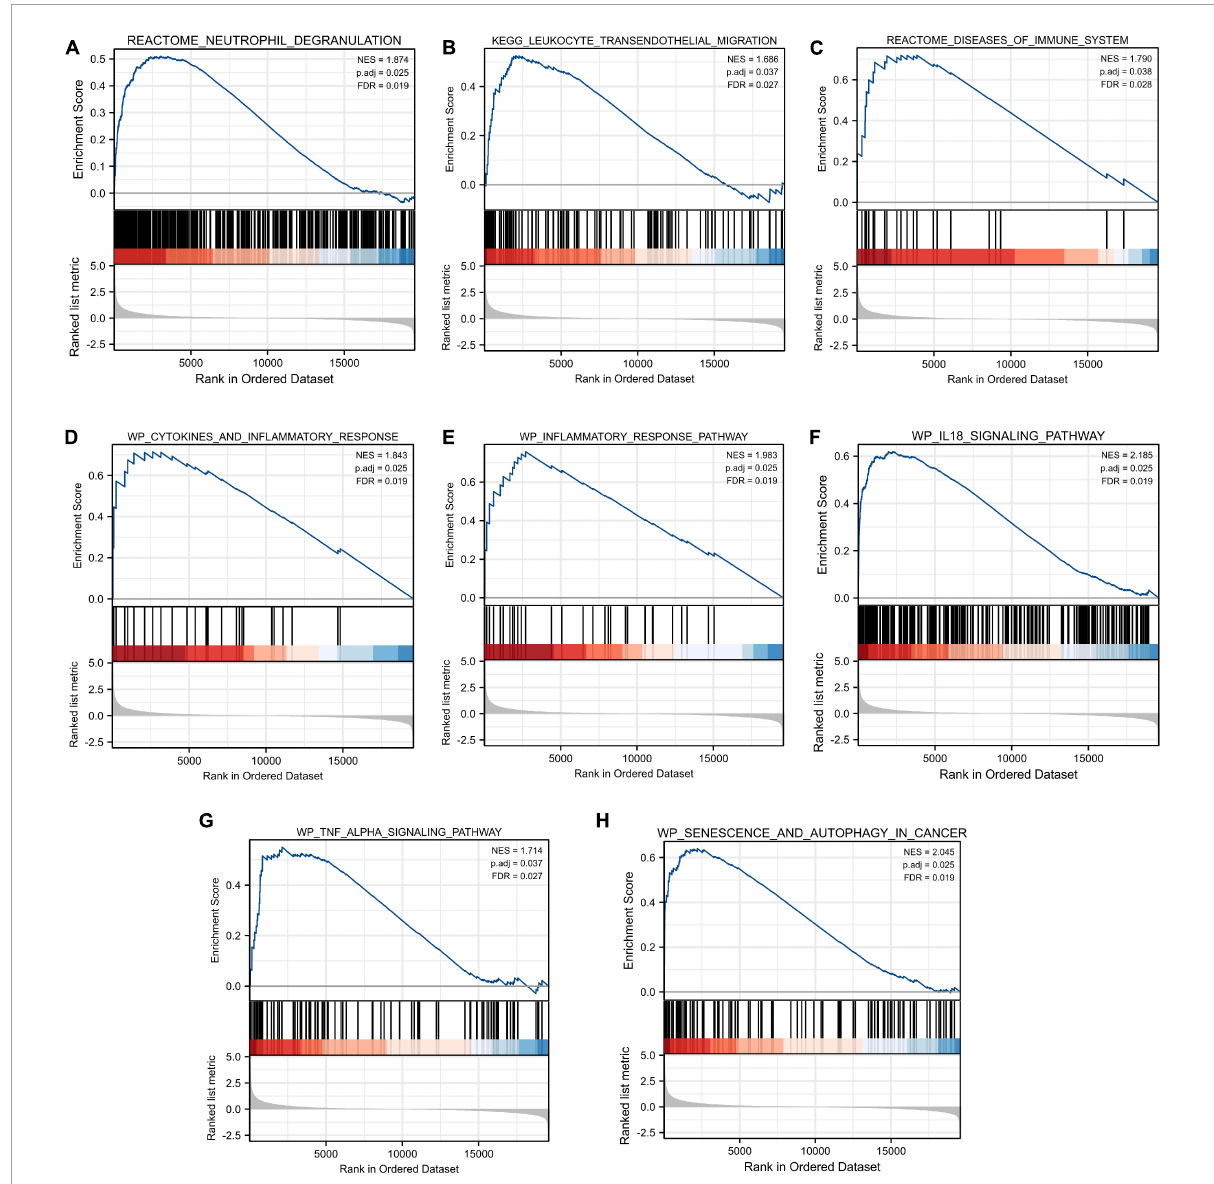
FIGURE5 Gene Set Enrichment Analysis (GSEA). FDR < 0.25 and p.adjust < 0.05 were considered to be significant. (A) Neutrophil degranulation, (B) leukocyte transendothelial migration, (C) disease of the immune system, (D) cytokines and inflammatory response, (E) inflammatory response pathway, (F) IL18 signaling pathway, (G) TNF alpha signaling pathway, and (H) senescence and autophagy in cancer were involved in the pathological process of TLE. The GSEA results showed that immune- and inflammation-related pathways were significantly associated with TLE